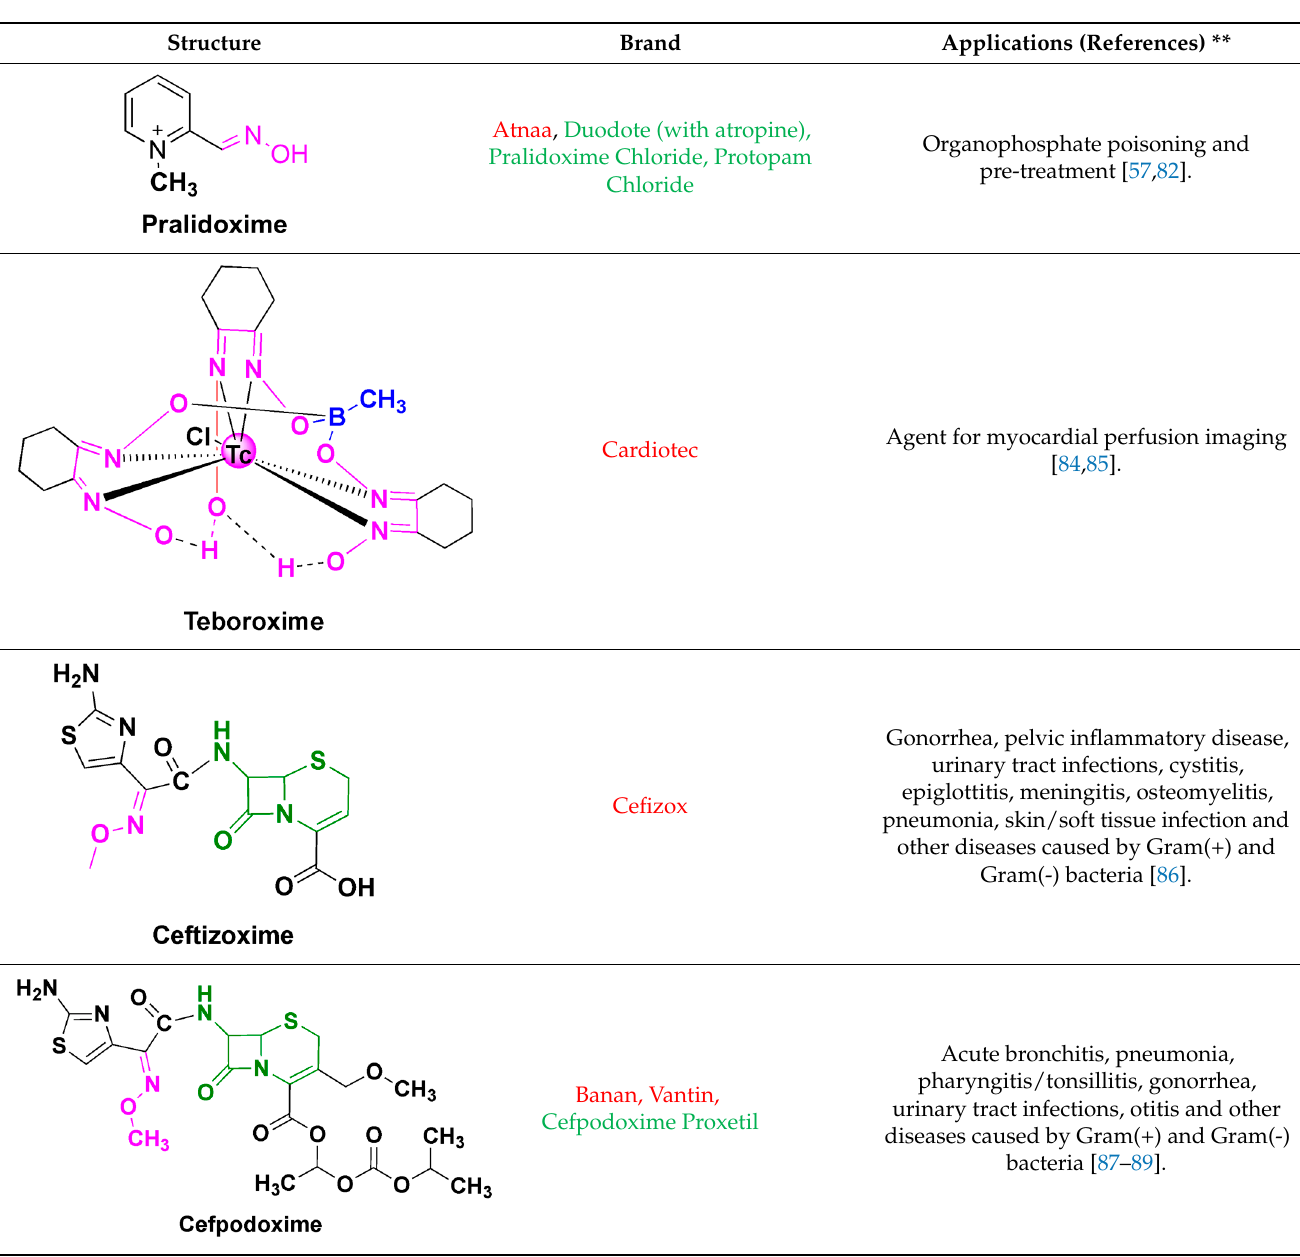
Table 2. FDA-approved oximes, their brand names (discontinued and active) and medicinal appli- cations. **: cited references.